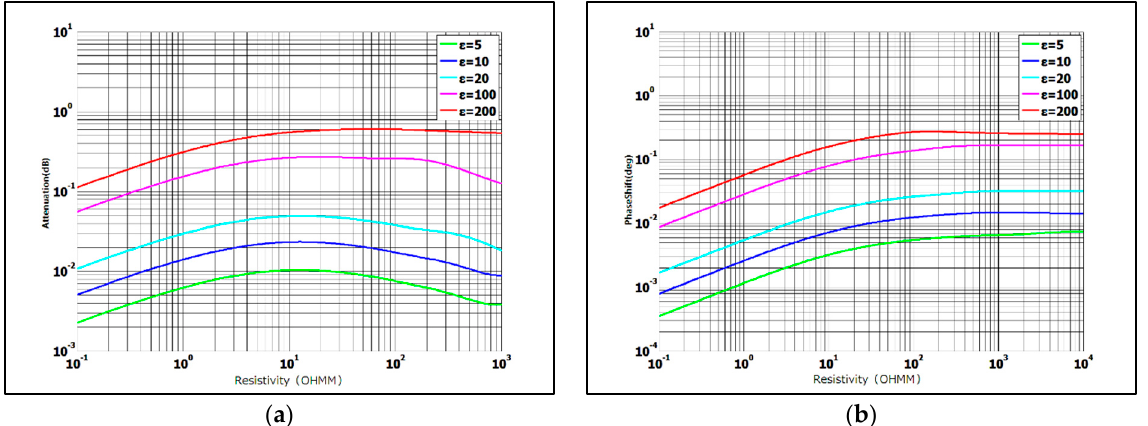
Figure 7. O ff set correction chart of resistivity conversion linked list under di ff erent dielectric con- Figure 7. Offset correction chart of resistivity conversion linked list under different dielectric con- stants: ( a ) resistivity–a tt enuation correction chart; ( b )resistivity–phase shift correction chart. stants: ( a ) resistivity–attenuation correction chart; ( b ) resistivity–phase shift correction